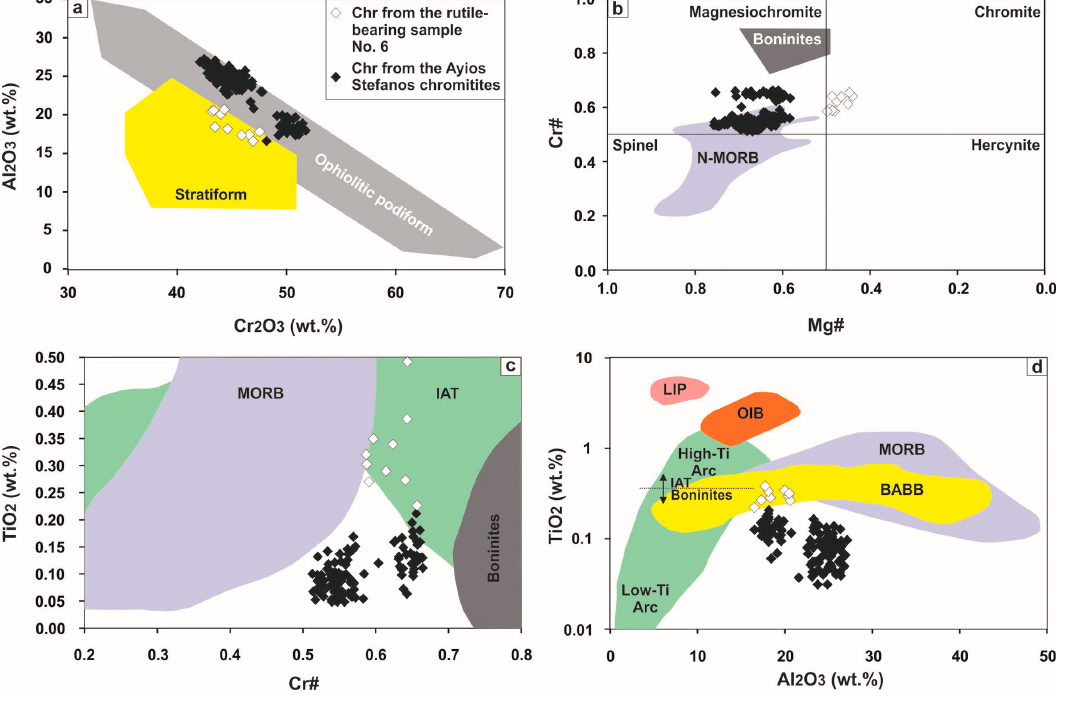
Figure 10. Pristine Cr-spinel composition in terms of: ( a ) Al 2 O 3 vs . Cr 2 O 3 ; ( b ) Cr# [= Cr/(Cr + Al)] vs. Mg# [= Mg/(Mg + Fe 2+ )]; ( c ) TiO 2 vs. Cr# and ( d ) TiO 2 vs. Al 2 O 3 (wt %). Fields for podiform and stratiform chromitites are from [42]. Fields for spinel in equilibrium with N-MORBs and boninites in ( b ) are from [43]. Fields for Cr-spinel in equilibrium with MORBs, IATs and boninites in ( c ) are from [44]. Compositional fields in ( d ) are from [45]. Abbreviations: (N-)MORBS = (normal) mid-ocean ridge basalts, IAT = island arc tholeiites, BABB = back-arc basin basalts; OIB = ocean islands basalts, LIP = large igneous province (basalts).